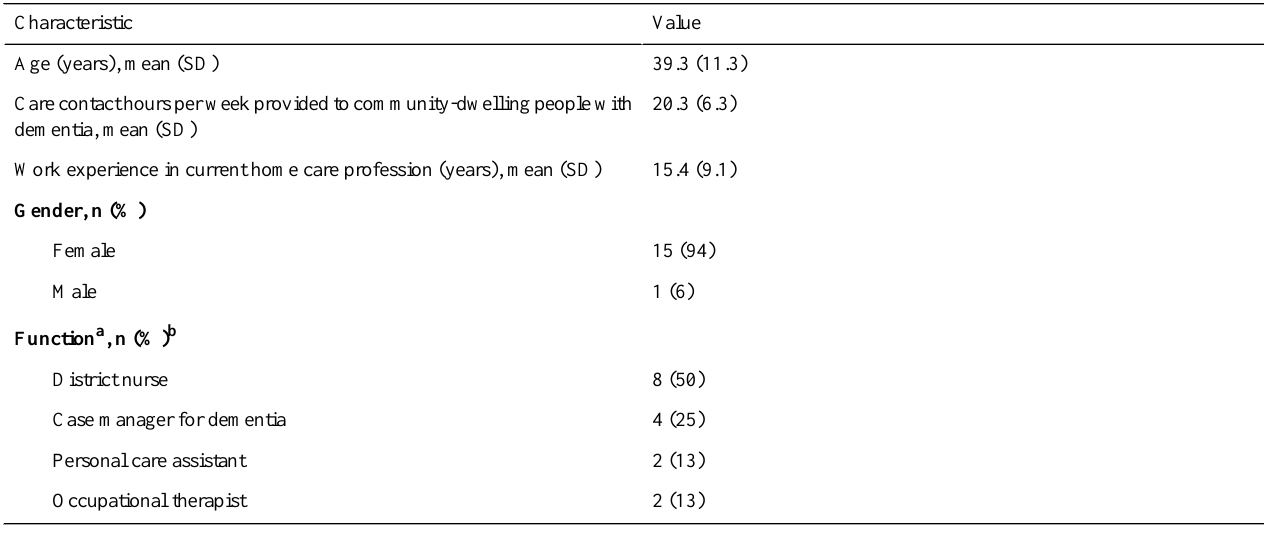
Table 2. Characteristics of formal caregivers